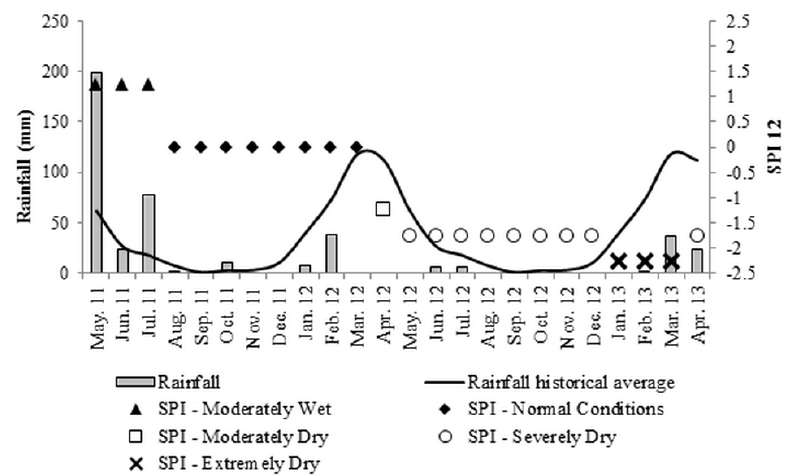
Figure 2. Monthly rainfall, rainfall historical average and standardized precipitation index (SPI 12) from May 2011 to April 2013 for Currais Novos